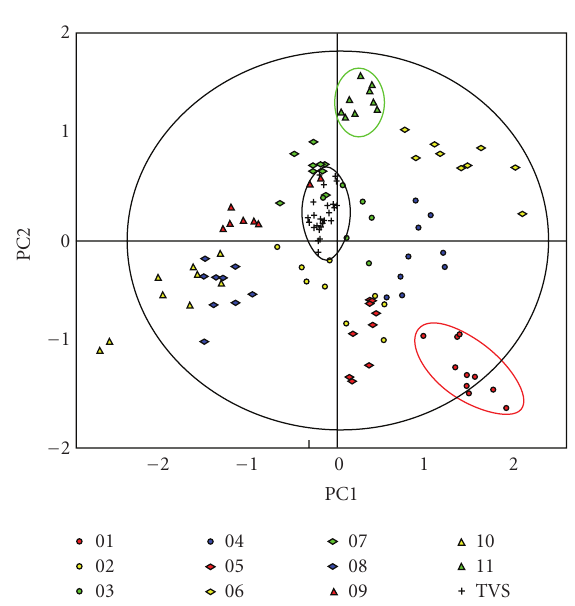
Figure 3: Principal component analysis of the 33 samples from the present study and the 8 replicates from the previous Technical Variation Study (TVS) [9], color-coded according to the legend, projected onto the first two principal components. Ellipses high- lighting subjects 1 (red), 11 (green), and the TVS (black) are added for illustrative purposes